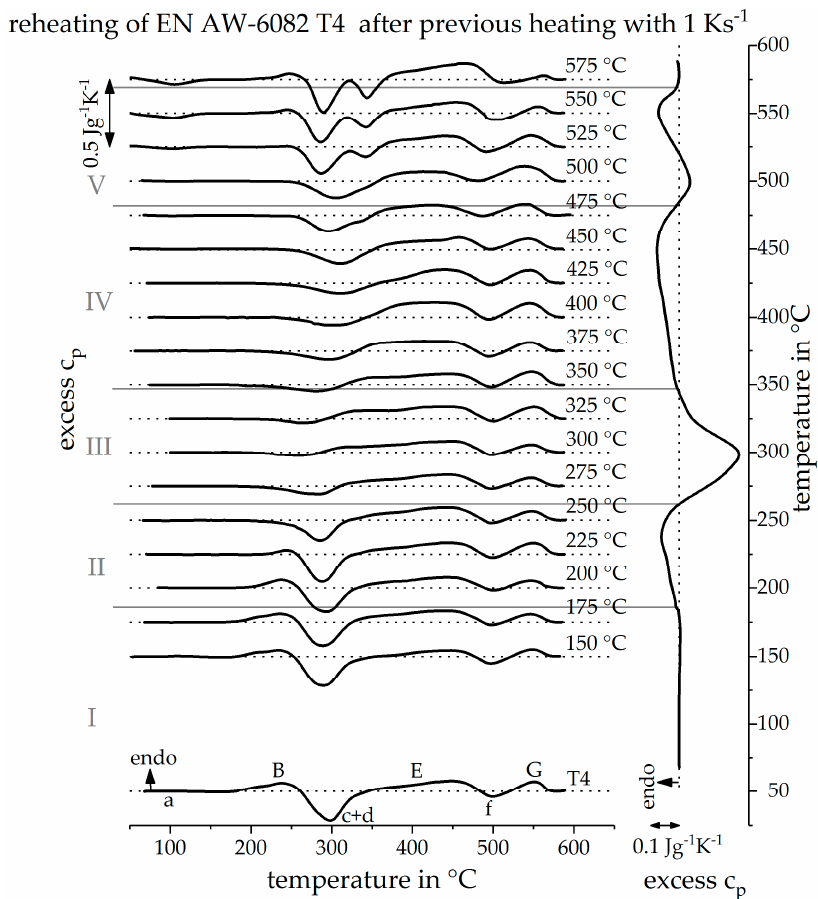
Figure 9. DSC reheating curves, after an initial heat treatment with a heating rate of 1 Ks − 1 , up to different maximum temperatures and the direct measured DSC heating curve at 1 Ks − 1 in comparison.